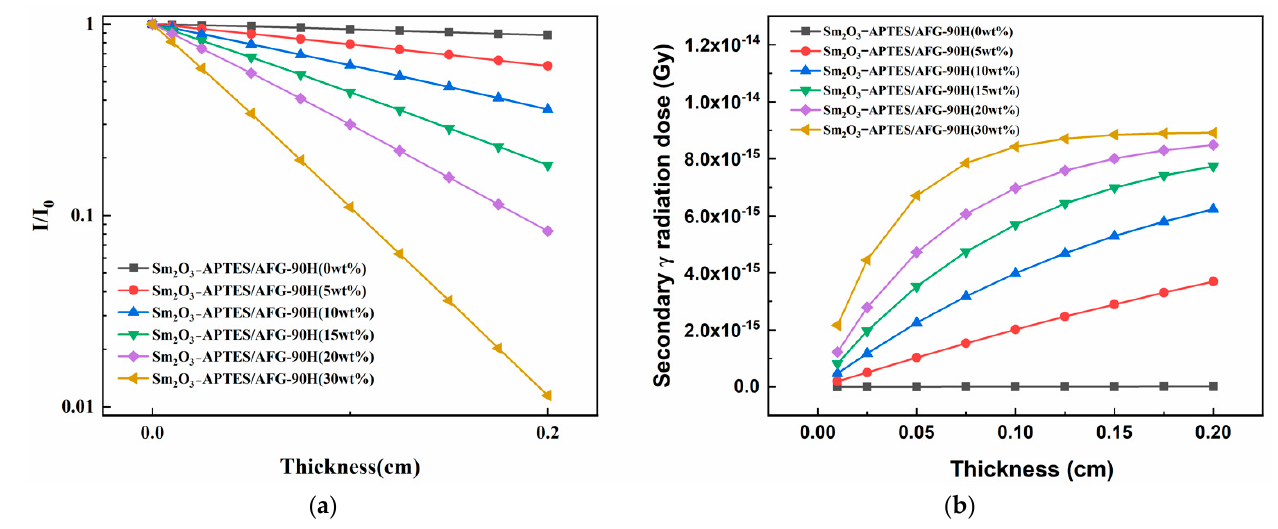
Figure 13. Shielding performance of Sm 2 O 3 -APTES/AFG-90H: ( a ) neutron permeability (I/I 0 ); ( b ) secondary γ dose.